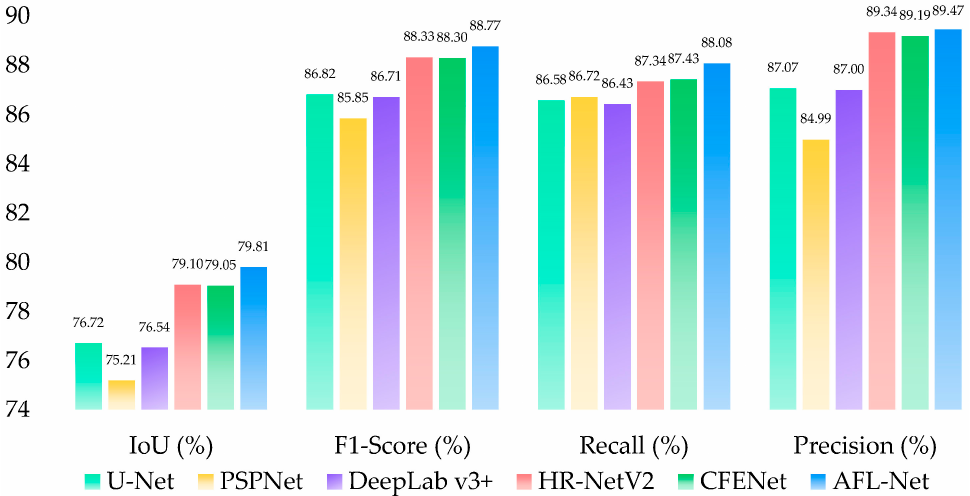
Figure 8. Comparative results from the selected models on the BITCC dataset.